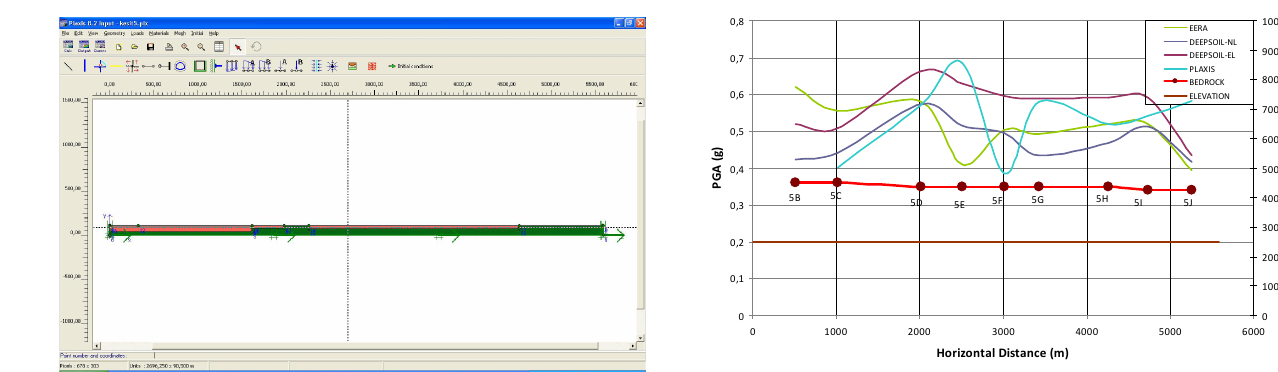
Figure 21: Change of Maximum acceleration by depth for 5 points chosen for the section